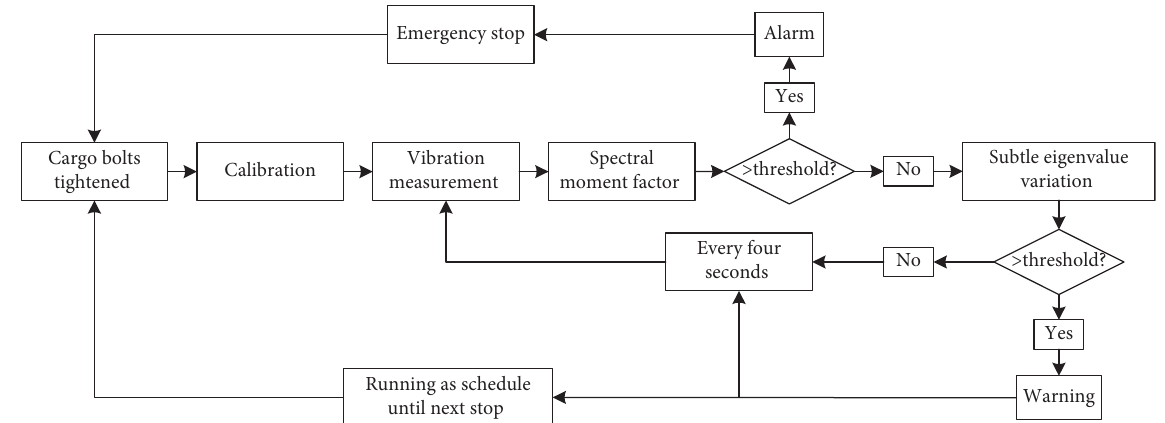
Figure 5: Flowchart of the proposed algorithm for cargo bolts monitoring.